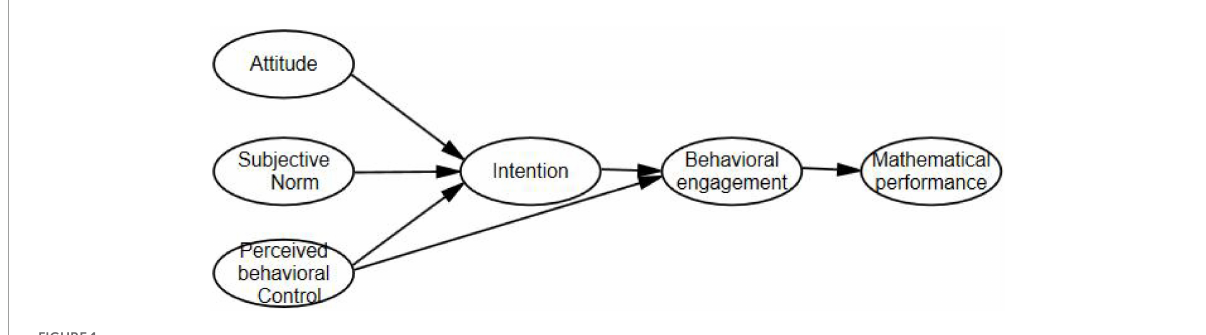
FIGURE1 Conceptual